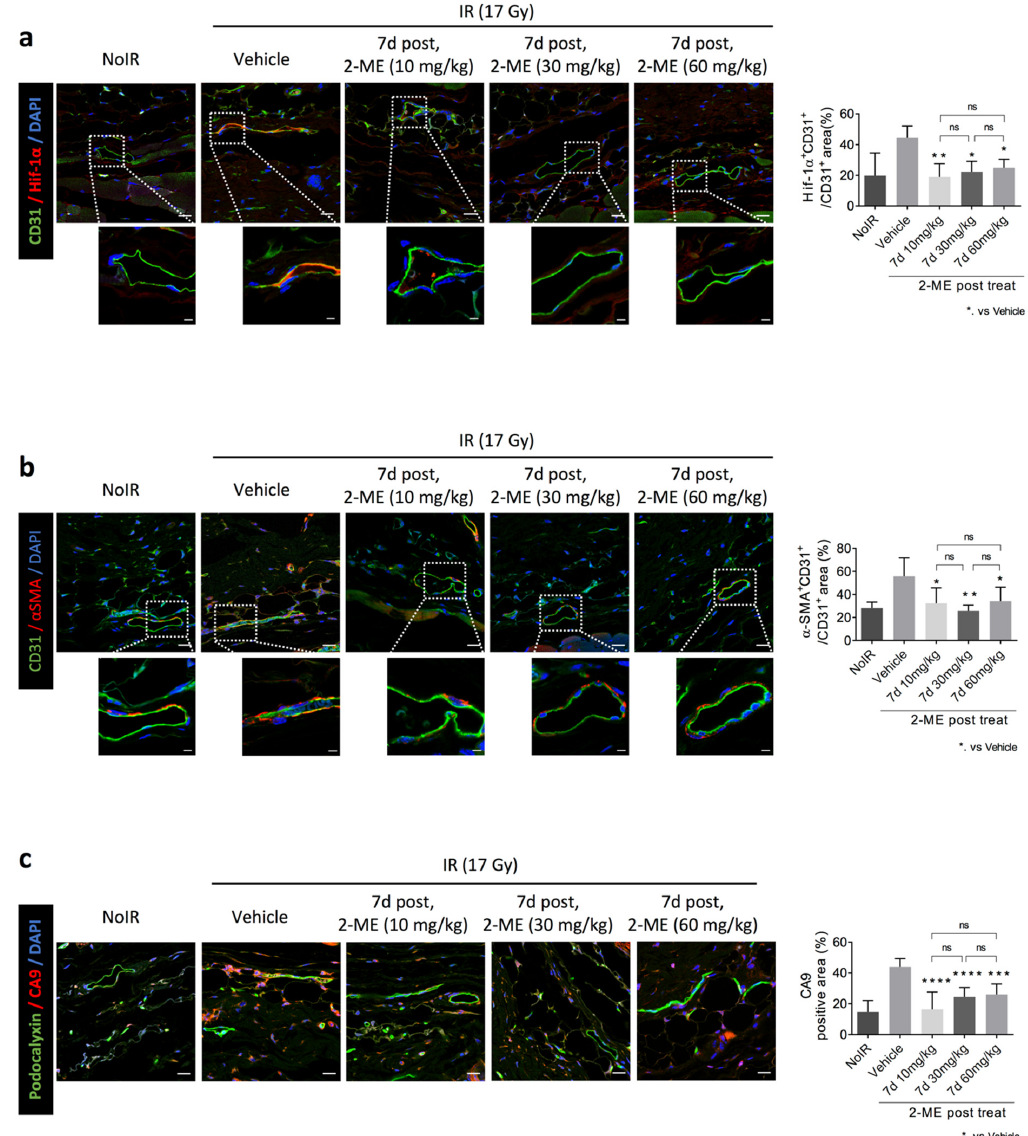
Figure 3. 2-ME inhibits irradiation-induced skin vascular EndMT, HIF-1 α expression, and CA9 expression. C57BL/6 mice skin was irradiated with 17 Gy using a 4-cm field. Mice were orally injected with 2-ME (30 mg/kg) 5 days and 7 days after irradiation a total of 6 times in 3 weeks. ( a ) Immunofluorescence staining of CD31 (green) and HIF-1 α in skin tissues from mice that were non-irradiated and irradiated with or without 2-ME treatment. Scale bar = 20 μ m; scale bar of the cropped images = 5 μ m. Quantification of the HIF-1 α + CD31 + colocalization area relative to CD31 + area as an average of five fields (magnification, 200×, n > 5). ( b ) Immunofluorescence staining of CD31 (green) and α SMA in skin tissues from mice that were non-irradiated and irradiated with or without 2-ME treatment. Scale bar = 20 μ m; scale bar of the cropped images = 5 μ m. Quantification of the HIF-1 α + CD31 + colocalization area relative to CD31 + area as an average of five fields (magnification, 200×, n > 5). ( c ) Immunofluorescence staining of CA9 and podocalyxin (green) in skin tissues from mice that were non-irradiated and irradiated with or without 2-ME treatment. Scale bar = 20 μ m. Quantification of the CA9 + area per field as an average of five fields (magnification, 200×, n > 5). For all graphs, error bars indicate the SD from n > 3 biologically independent experiments (one-way ANOVA for multiple comparisons). * p < 0.05, ** p < 0.01, *** p < 0.001, and **** p < 0.0001.